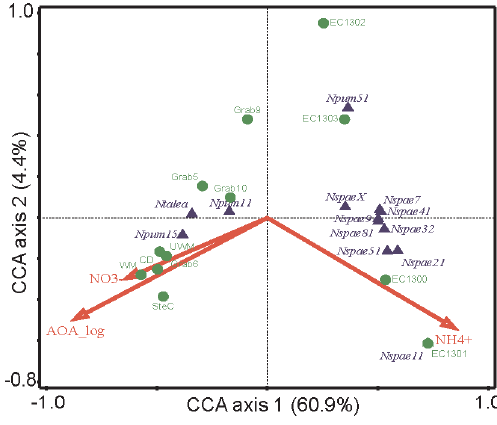
Figure 7. Canonical correspondence analysis (CCA) triplot (arrows: environmental variables; circles: samples; triangles: species) for quantitative data as presented in Fig. 3 of the AOA amoA sequence libraries in Lake Erie and Superior (Eigenval- ues: Axis 1: 0.5865, Axis 2: 0.0421, Axis 3: 0.0073). Explanatory value of the environmental factors was determined using forward selection: AOA_log explained 47%; ammonium concentration 18.3% and nitrate concentration 0.8% of the variation.